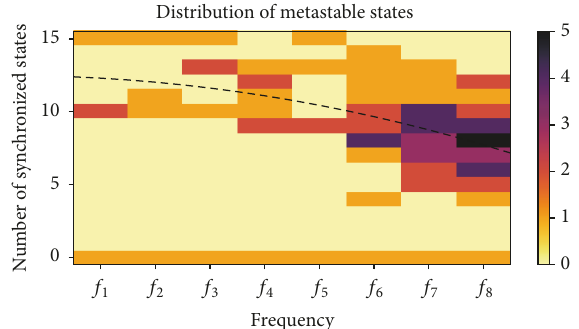
Figure 3: Distribution of metastable states by frequency and synchronized nodes. Distribution of the number of active (i.e., synchronized) states of the inferred Ising models for each frequency band. The horizontal axis represents the frequency band, the vertical axis represents the number of active states of the metastable states, and the colour represents the count of metastable states with the same number of active states. The dashed line is the result of a least squares second-order polynomial fit (higher orders show a similar trend) over the number of active nodes of metastable states (excluding states with zero active nodes) with respect to the frequency index, showing a decrease of the number of synchronized nodes in the metastable states in favour of local clusters of